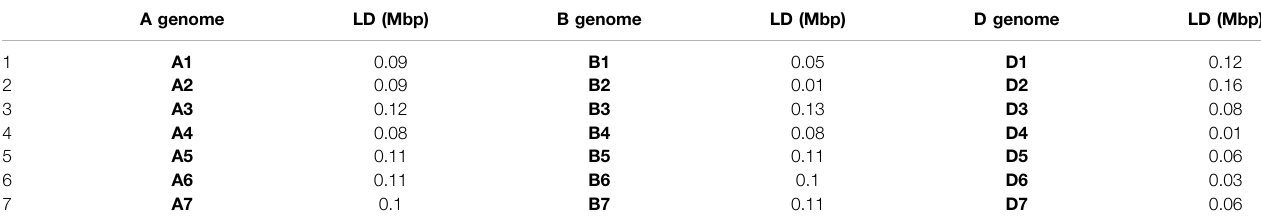
TABLE 4 | Chromosome-wise linkage disequilibrium (LD) of individual chromosome. A genome LD